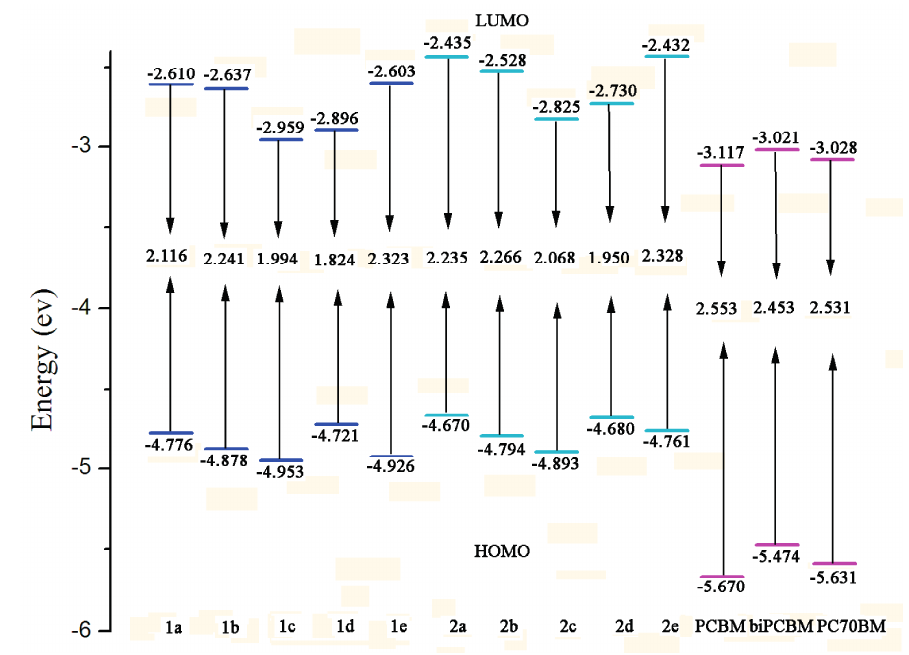
Figure 2. Evaluation of calculated FMO energies for investigated molecules as well as FMO energies for PCBM, bisPCBM, and PC70BM at the B3LYP/6-31G(d,p)